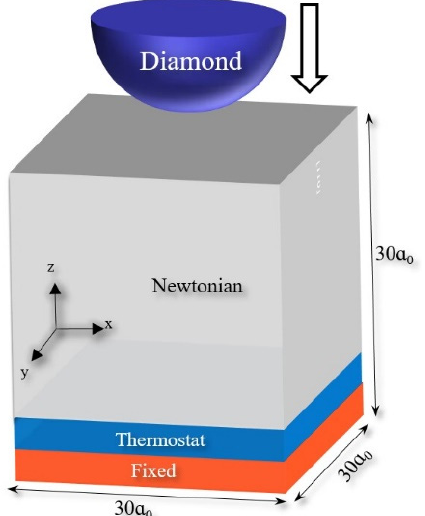
Figure 1. Schematic diagram of the MD simulation model: nanoindentation of M50 bearing steel. The orange fixed layer is 5 𝑎 (cid:2868) thick, the blue thermostatic layer is 5 𝑎 (cid:2868) thick, and the gray Newtonian layer has an atomic layer thickness of 20 𝑎 (cid:2868) . Here, the value of 𝑎 (cid:2868) is 2.855